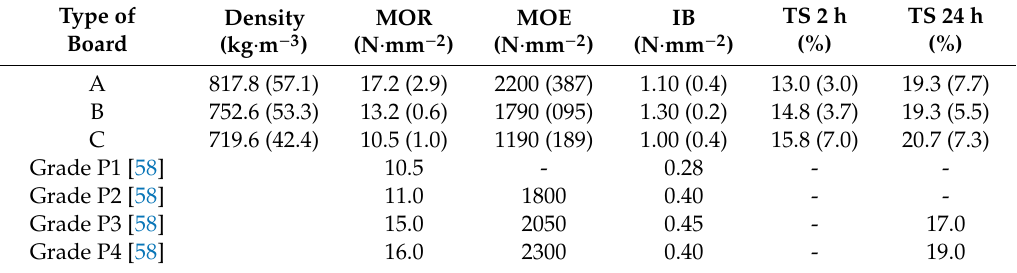
Table 4. Physical and mechanical properties of giant reed particleboards.